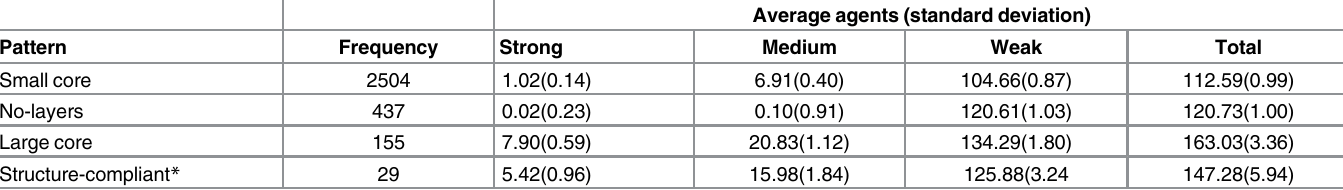
Table 1. Mean number of agents in each layer in the four different final social patterns identified by cluster